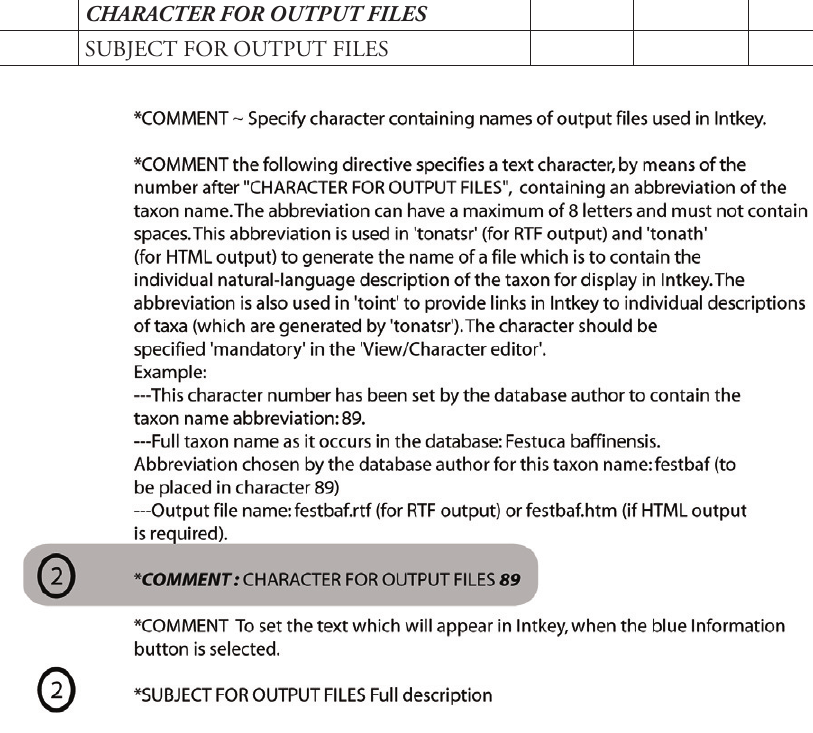
Figure 34. Th e ofi les directive fi le contains data for the automatic naming of fi les created with tonatsr . Th e numbers to left of the directive fi le indicate diff erent classes of directives (see in Table 7). Th e grey oval shows command where input of the user might be required.